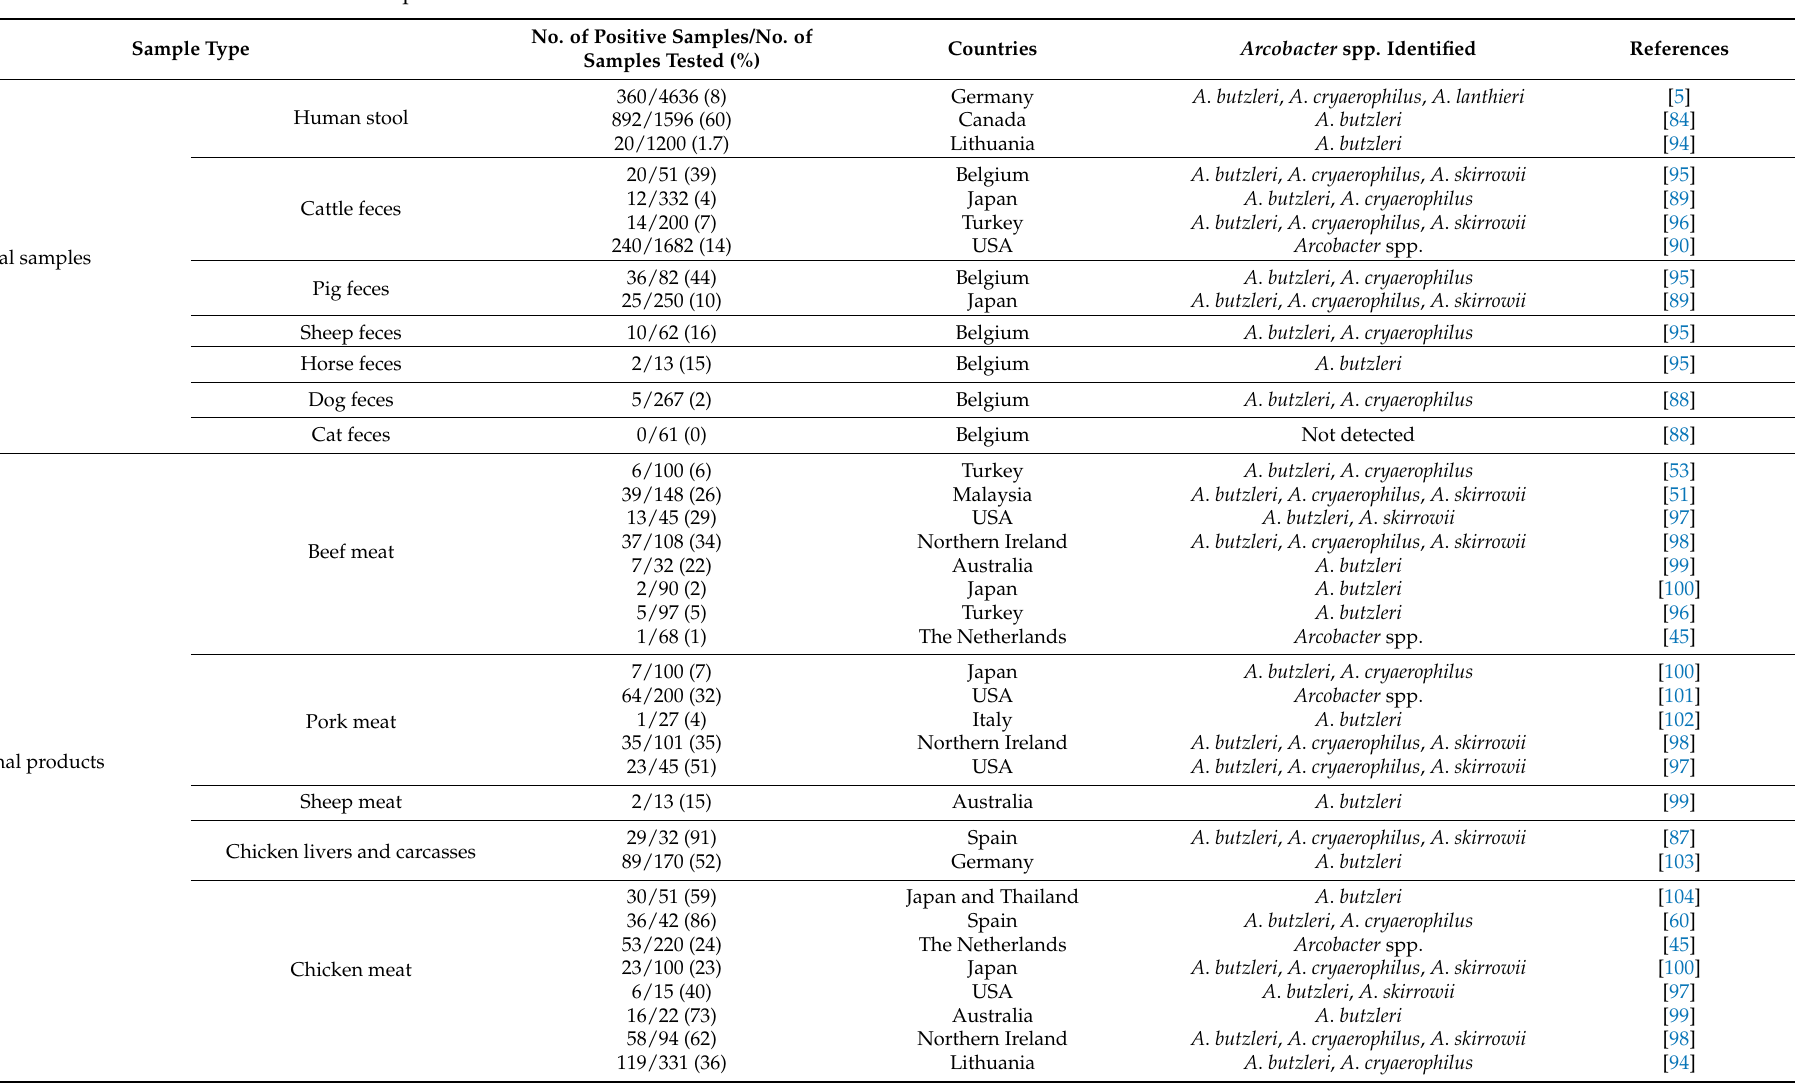
Table 5. Various samples from which Arcobacter was detected and